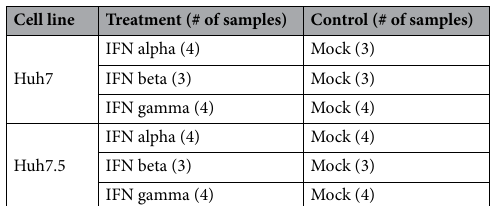
Table 1. Experimental design. The 6 biological comparisons (3 treatments in each cell line) are described with the number of biological replicates (from 3 to 4) for each condition in parenthesis.